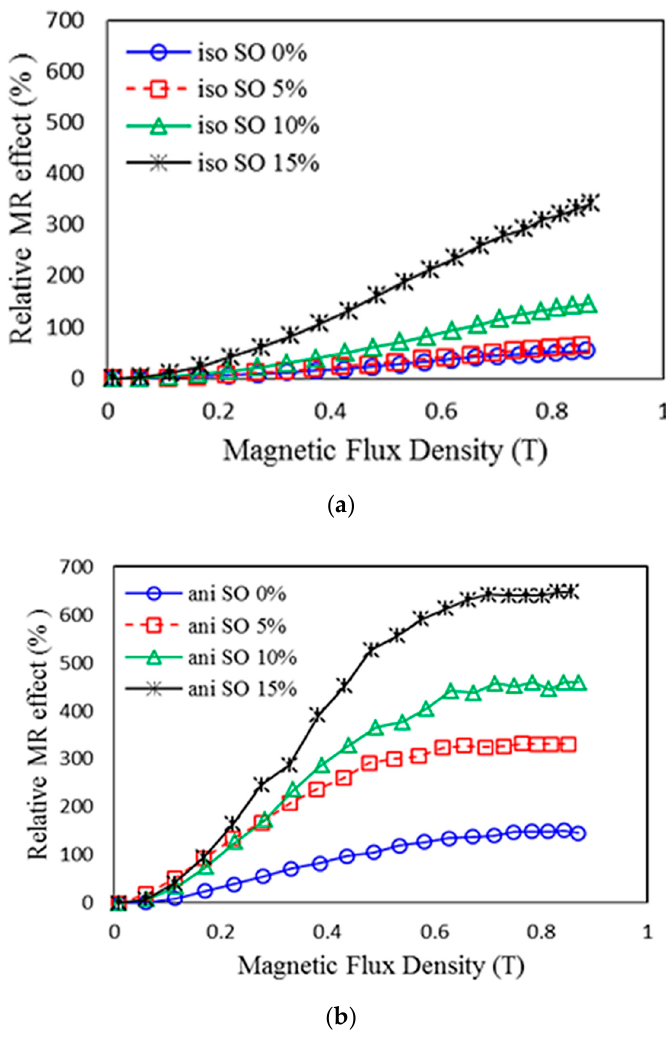
Figure 3. Relative MR e ff ect for ( a ) isotropic MRE and ( b ) anisotropic MRE as a function of sweep magnetic field at various contents of SO. Table 1. The zero-field storage modulus ( G 0 ), the magnetic induced modulus ( ∆ G ), and the MR e ff ect of the MRE with di ff erent contents of